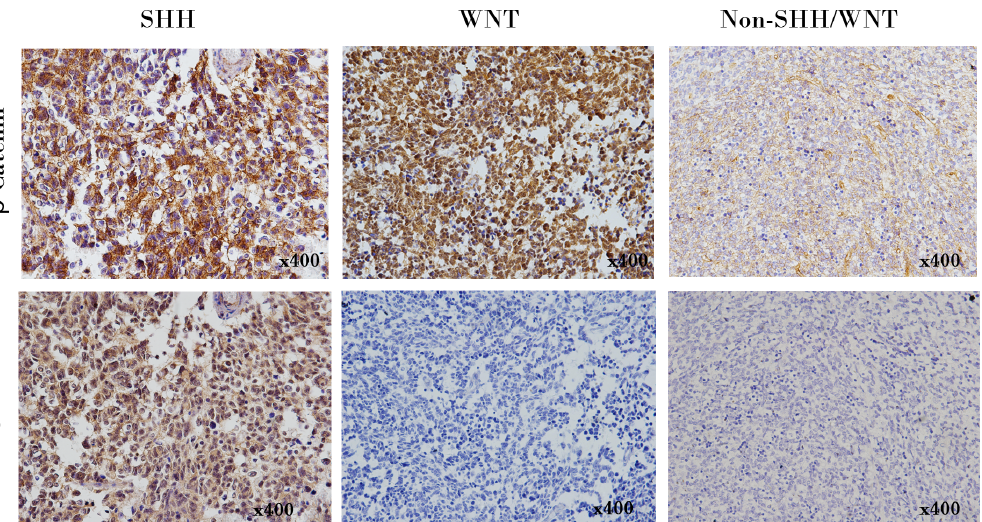
Figure 1. Molecular classification of medulloblastoma by immunohistochemical staining. 173 cases were classified into SHH subgroup ( b -Catenin cytoplasmic-positive, GAB1 cytoplasmic-positive), WNT subgroup ( b -Catenin nuclear + cytoplasmic-positive, GAB1-negative) and Non-SHH/WNT subgroup ( b -Catenin cytoplasmic-positive, GAB1-negative). Representative photomicrographs of each subgroup are shown.